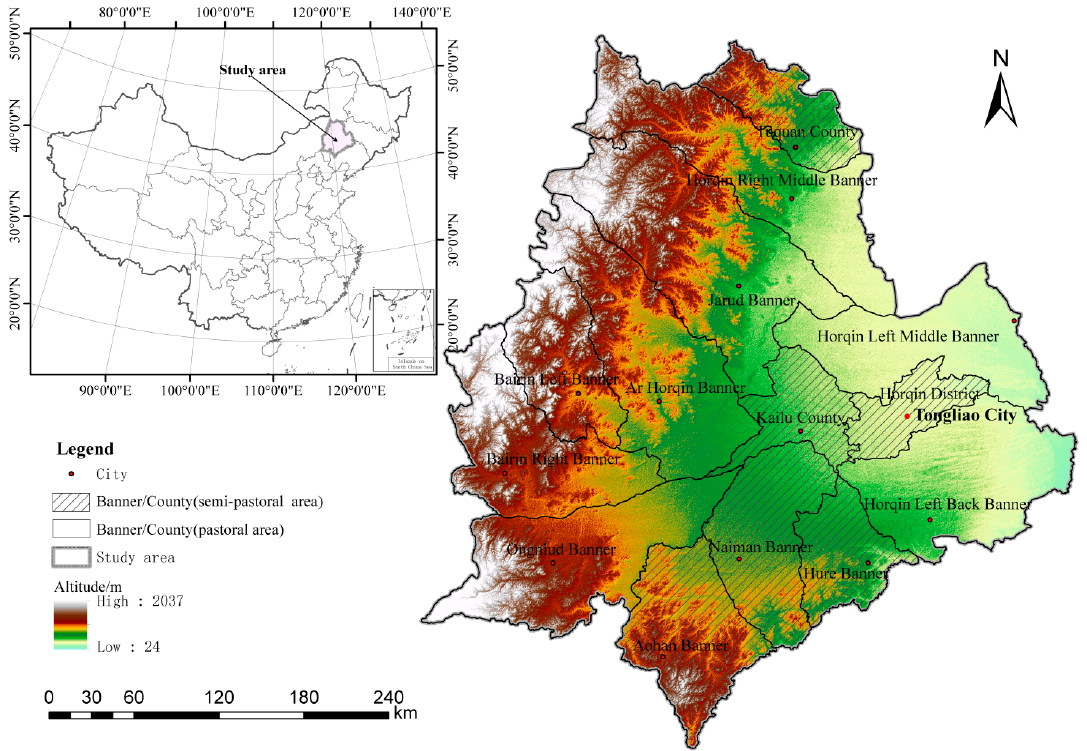
Figure 1. Location of the study area.